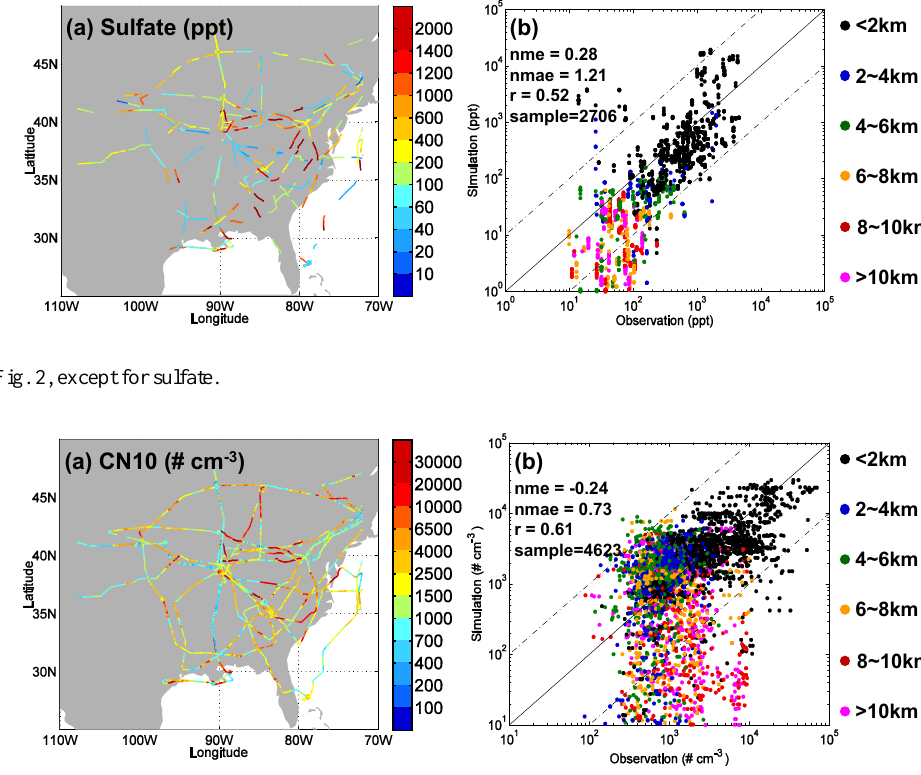
Fig. 4. Same as Fig. 2, except for the number concentration of condensation nuclei larger than 10nm